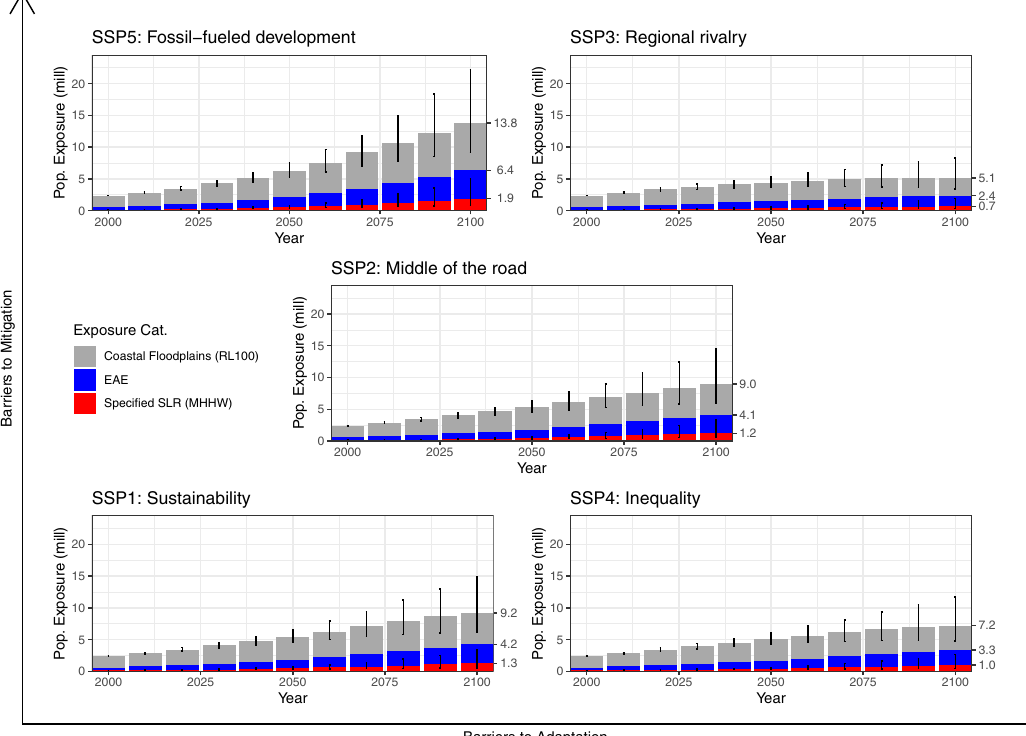
Fig. 1 Projections of sea level rise fl ooding exposure under Representative Concentration Pathway 4.5 and all fi ve Shared Socioeconomic Pathways (SSPs) for 2000 to 2100. Uncertainty re fl ects the 95 th percentile prediction interval. Each spatial zone is not mutually exclusive, but cumulative. 9.2 million people in the Infrequent Flooding Effects zone under SSP1 is inclusive of those in the two preceding zones.